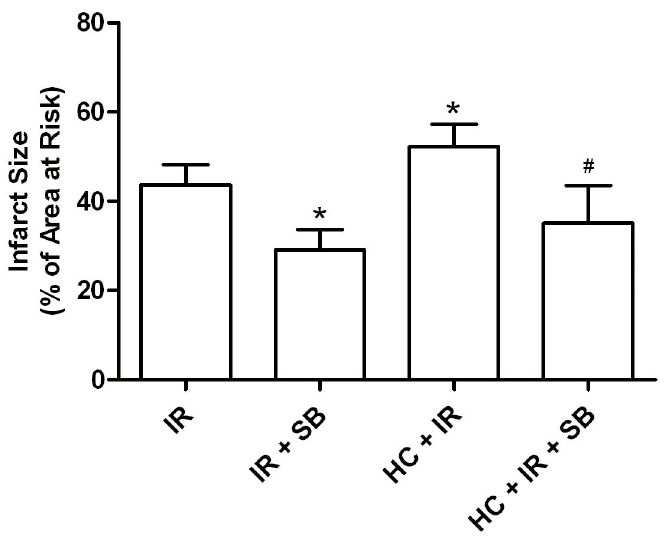
Figure 5. Effects of GSK3β inhibitor SB216763 on infarct size expressed as a percentage of area at risk in rat hearts exposed to ischemia-reperfusion. IR: ischemia reperfusion; SB: SB216763; HC: hypercholesterolemia. Data are mean ± SD, n = 8 hearts/group. * P < 0.05 vs . IR; # P < 0.05 vs . HC + IR.